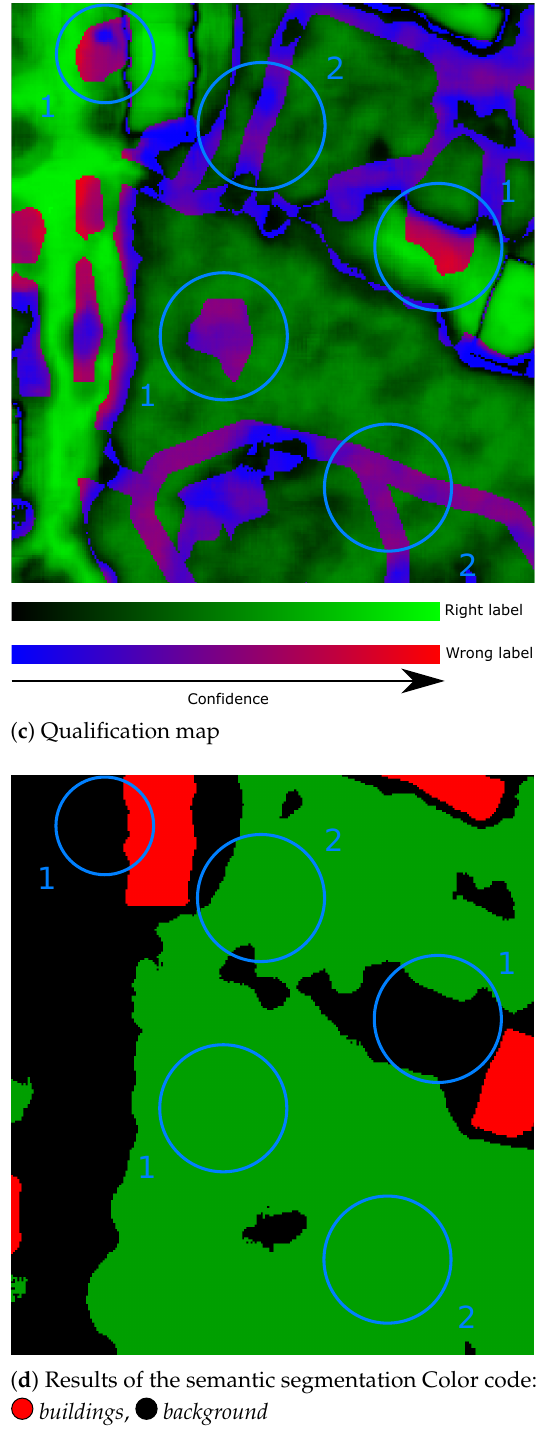
Figure 10. Visual results of our Bayesian U-Net on a small area of the Toulouse dataset. Blue circles correspond to: (1)-Wrong label in the database, (2)-Overlap between tree and walking path (labeled as background in the